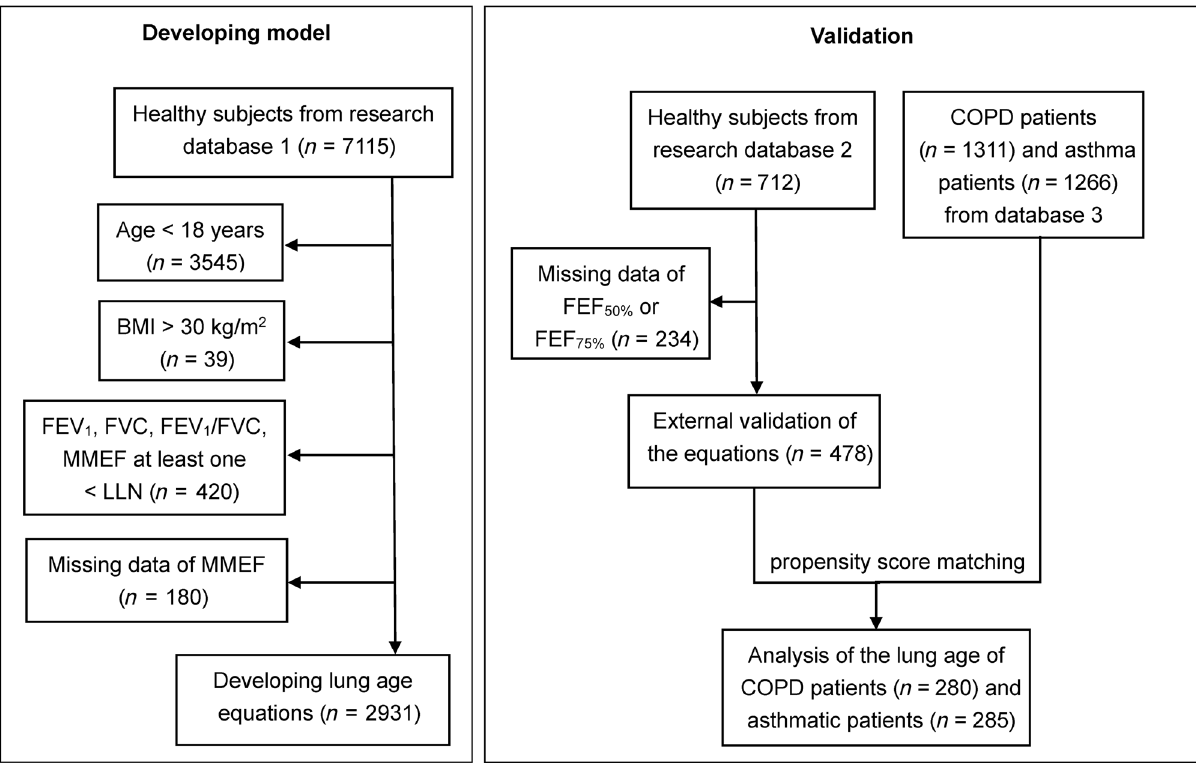
Fig. 1 Study fl ow chart. The left panel displays the data inclusion and exclusion of healthy subjects in the modelling group, the right panel displays the data inclusion and exclusion of healthy subjects in the validation group and patients with COPD and asthma.